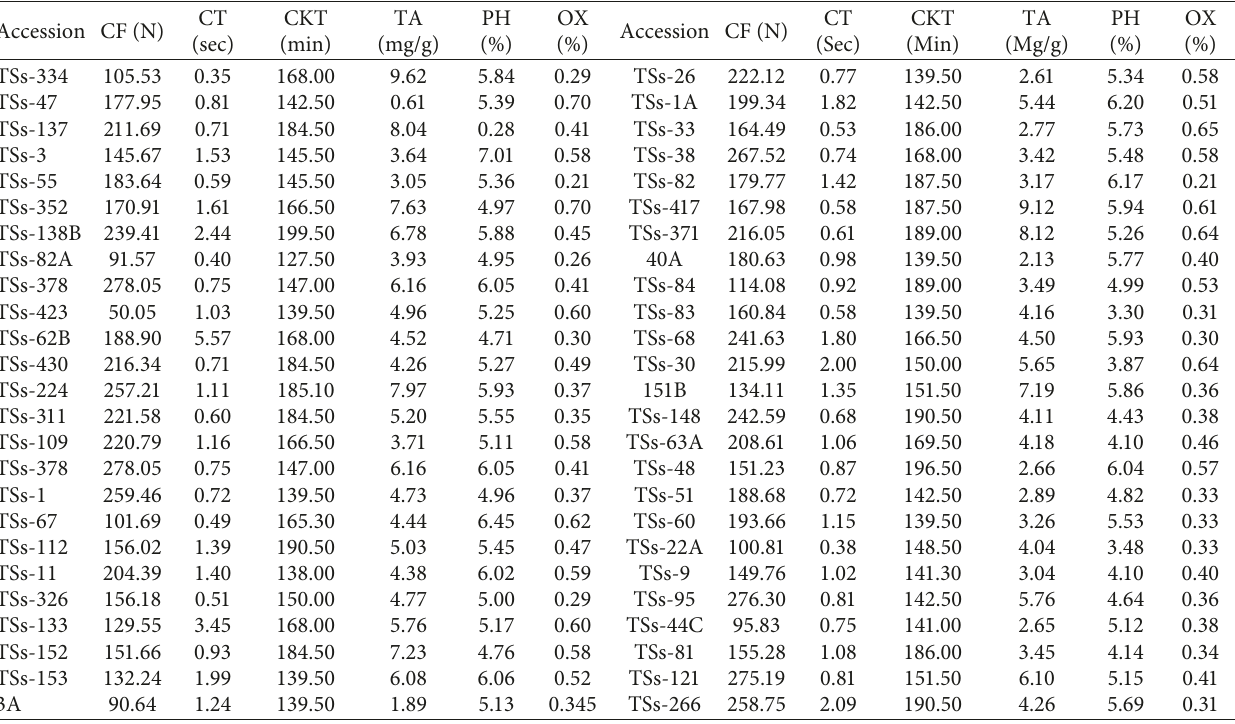
Table 5: Textural and chemical profiling of 50 AYB accessions.